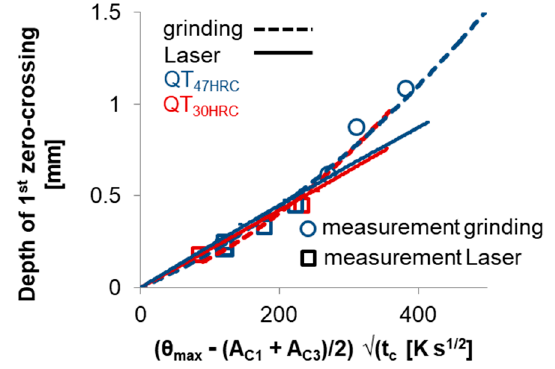
Figure 18. 1st zero-crossing: Simulation study for grind and laser hardening and comparison with measured data for grind and laser hardening.